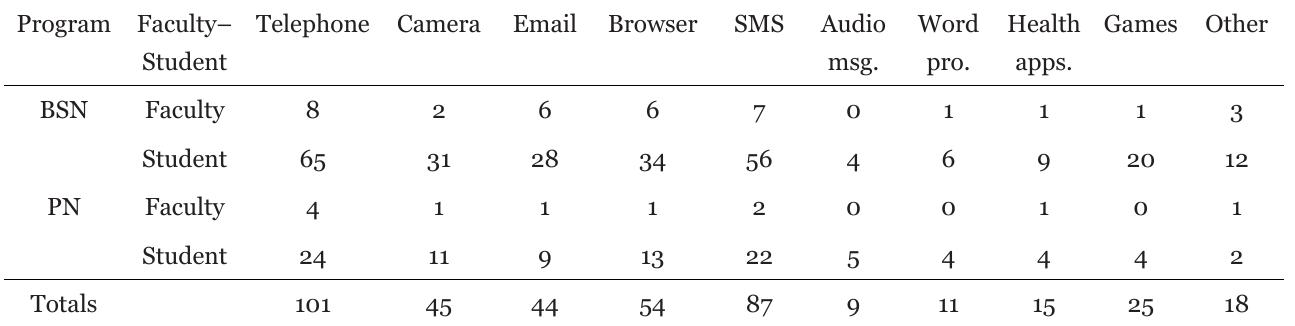
Mobile Device Features Used at Least Once a Week